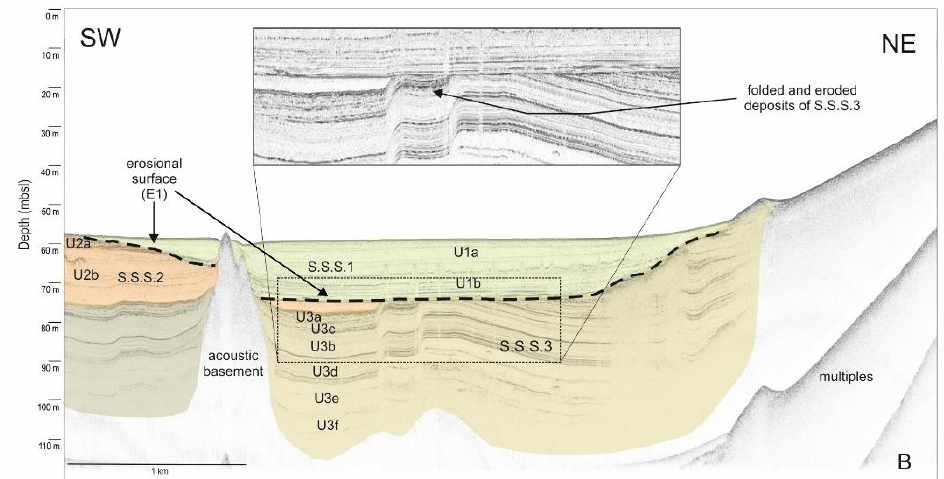
Figure 6. ( A ) High-resolution seismic profile of seismic line T10 and ( B ) its stratigraphic interpretation. The location of the line is shown in Figure 1.